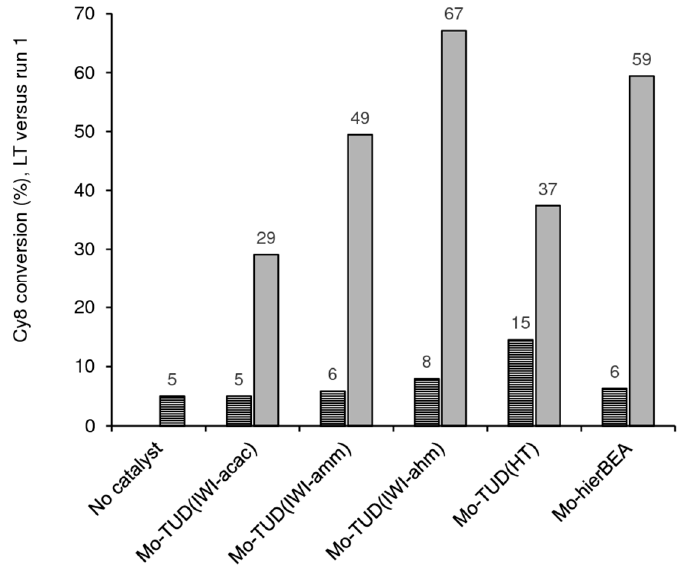
Figure 13. Increment of Cy8 conversion (between 30 min and 6 h, at 70 °C) for the leaching test (LT) (striped black bars), compared with the increment of conversion (in the same time interval) in the presence of solid catalyst (run 1; grey bars). The results for the reaction without catalyst are included.